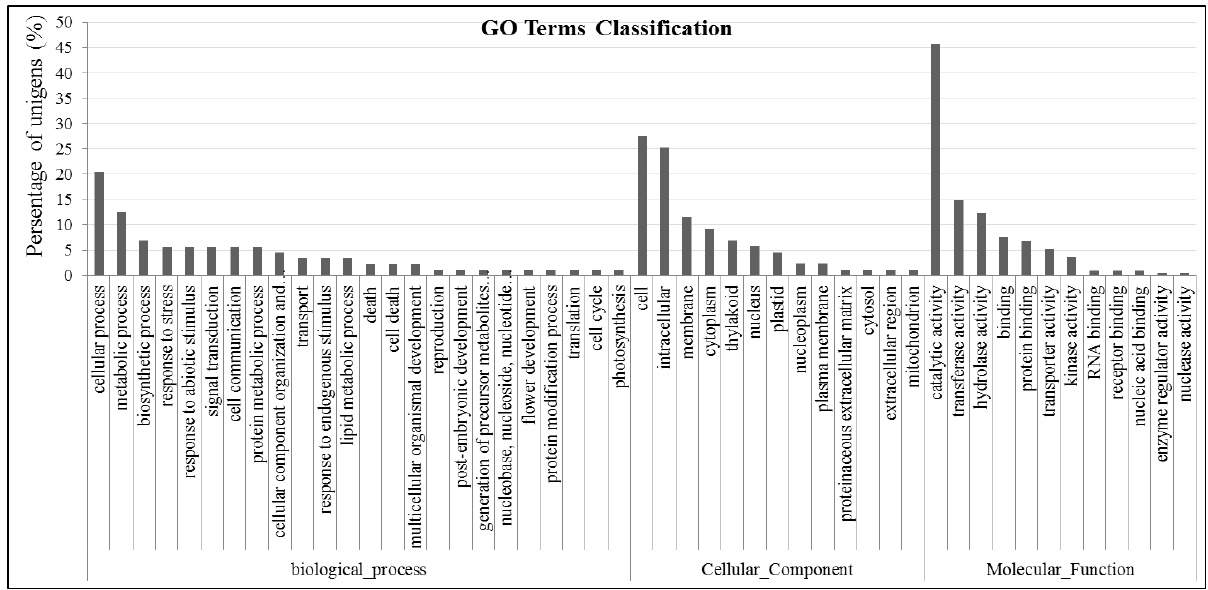
Figure 5. GO classification of the ESTs based on their biological functions, cellular components and molecular functions in the A. canescens cDNA